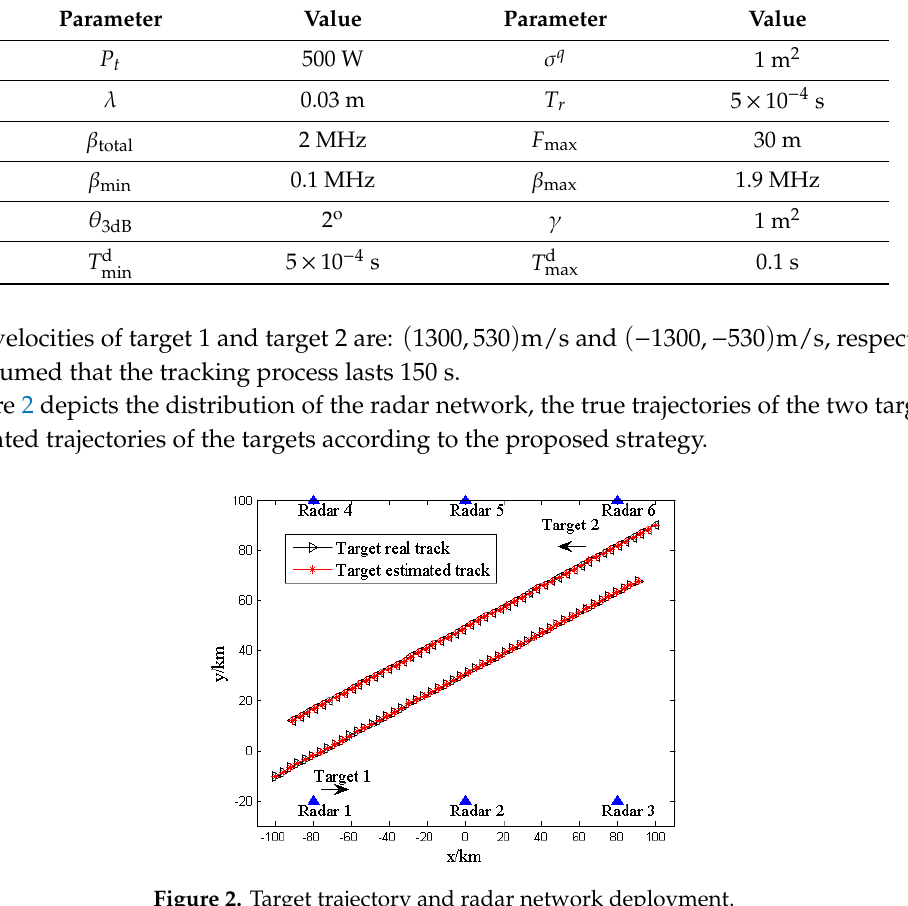
Figure 2. Target trajectory and radar network deployment.